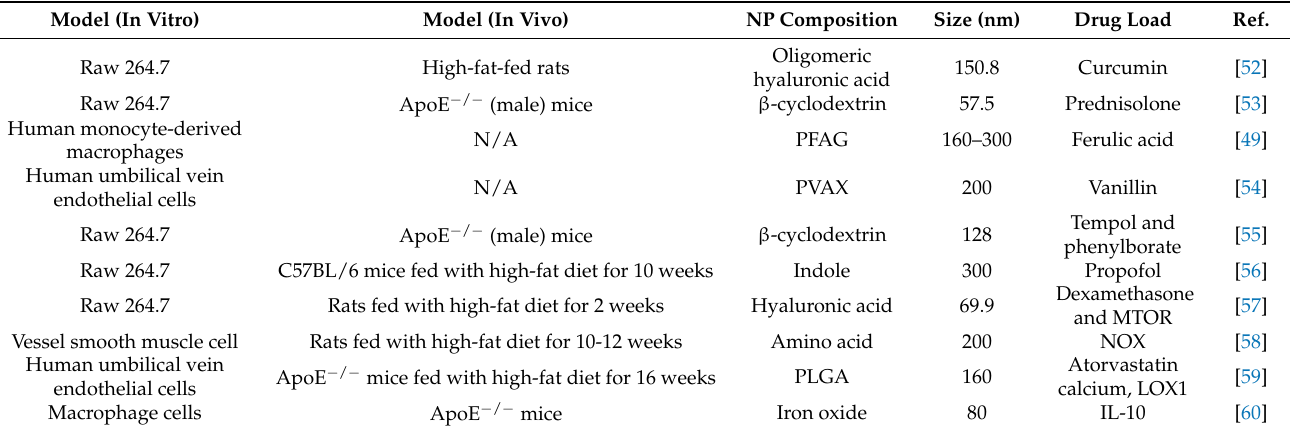
Table 1. ROS-based